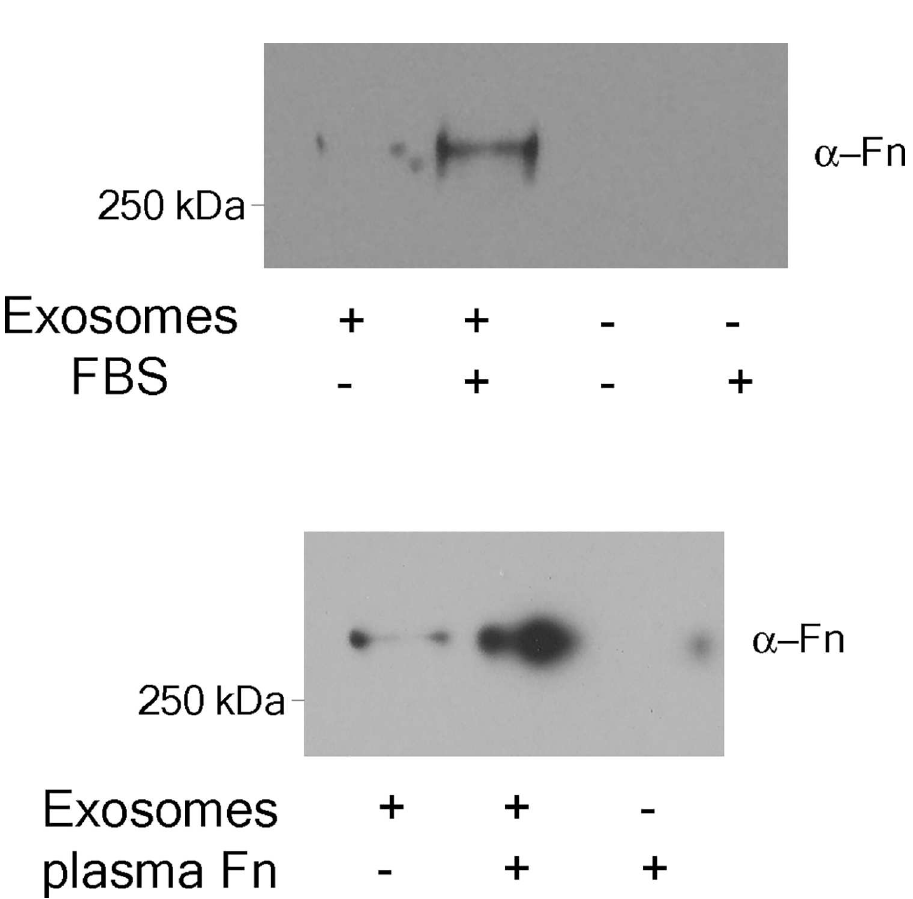
Fig 3. Trabecular meshwork (TM) exosomes bind fibronectin on the external surface. Serum-free medium was conditionedfor 2.5 hours with primary TM cell cultures. Conditioned media was split in half and either exosome-depleted FBS (10% final v:v) or purifiedhuman plasma fibronectin (Fn, 2.5 μ g/ml [final]) was added to one portion. Exosomes were preparedfrom both portions (and from unconditioned media + FBS or purifiedFn) and Fn content was assessed by Western blot. The blots shown represent the results from a minimum 3 biologicalreplicates(cell strains isolated from different human donors).